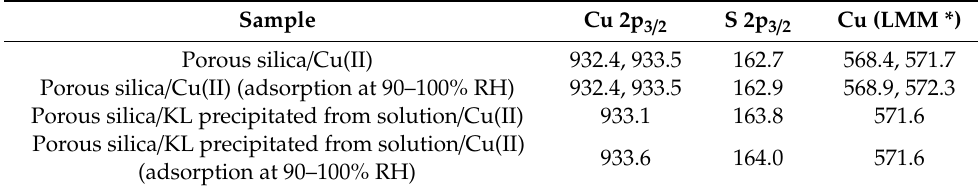
Table 2. X-ray photoelectron spectroscopy data for adsorbent materials after H 2 S removal.